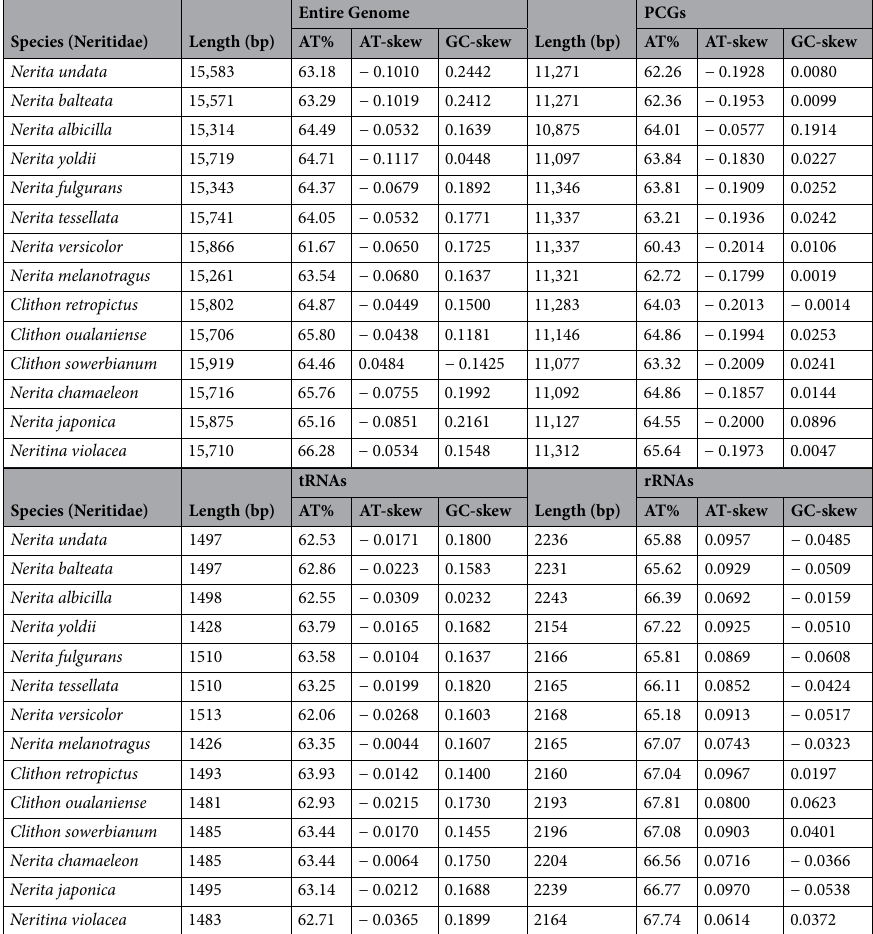
Table 4. Summary of the base composition of the mitogenomes from 14 species in family Neritidae of the